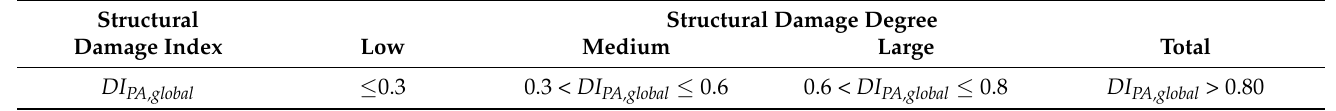
Table 1. Structural damage grade classification according to DI PA,global .